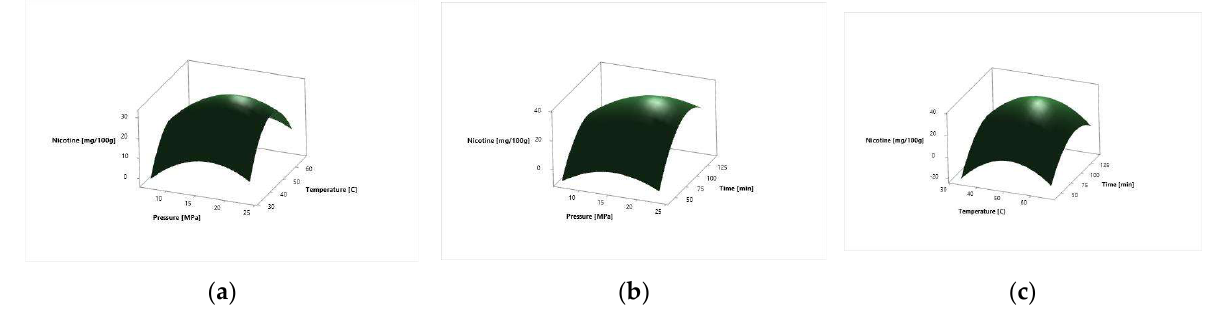
Figure 4. Surface response plots for the N. tabacum cv. Virginia leaves nicotine relative amount in a function of extraction: ( a ) pressure and temperature; ( b ) pressure and time; and ( c ) temperature and time.